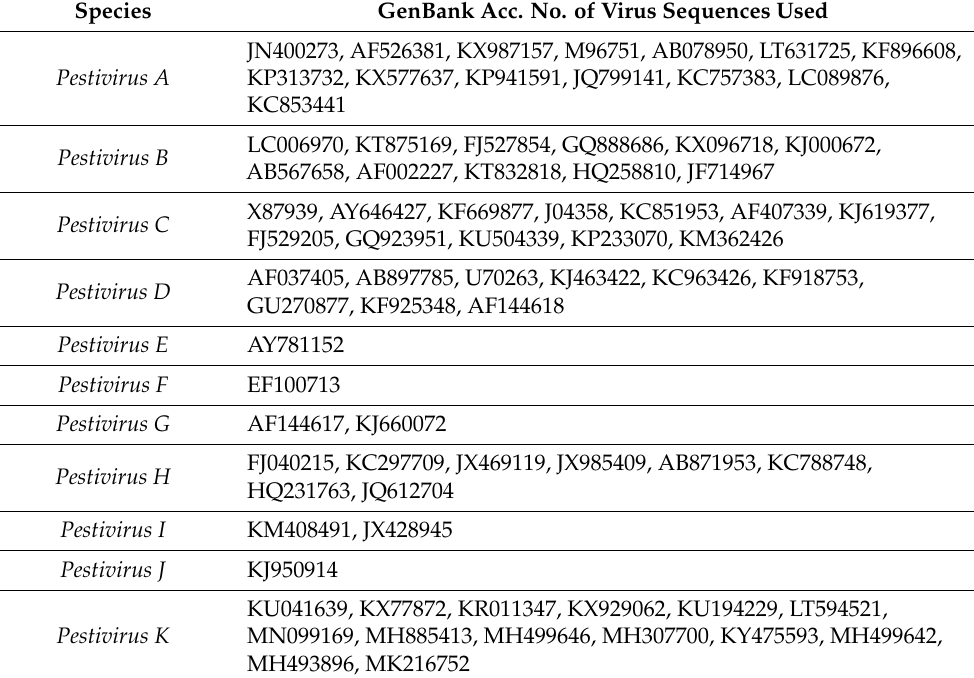
Table 2. GenBank accession numbers of reference